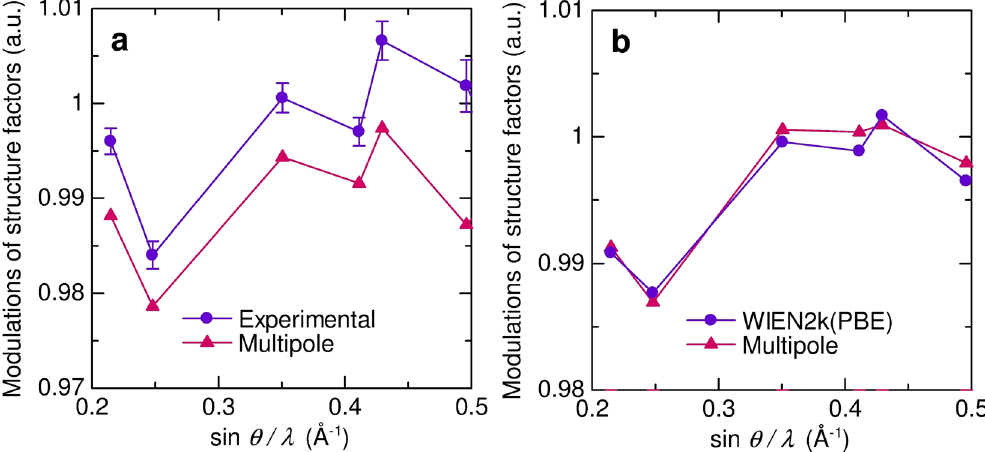
Figure 2. Relative ratio of structure factors to IAM. Horizontal axis is reciprocal resolution sin θ / λ . ( a ) The present experimental and multipole model values. ( b ) The present theoretical and multipole model